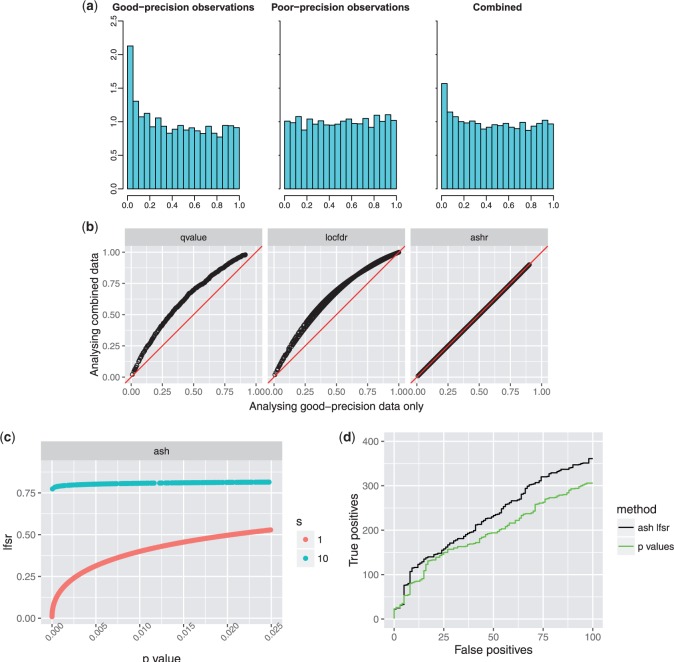
Simulations showing how, with existing methods, but not ash, poor-precision observations can contaminate signal from good-precision observations. (a) Density histograms of \documentclass[12pt]{minimal}
\usepackage{amsmath}
\usepackage{wasysym}
\usepackage{amsfonts}
\usepackage{amssymb}
\usepackage{amsbsy}
\usepackage{upgreek}
\usepackage{mathrsfs}
\setlength{\oddsidemargin}{-69pt}
\begin{document}
}{}$p$\end{document} values for good-precision, poor-precision, and combined observations. The combined data show less signal than the good-precision data, due to the contamination effect of the poor-precision measurements. (b) Results of different methods applied to good-precision observations only (\documentclass[12pt]{minimal}
\usepackage{amsmath}
\usepackage{wasysym}
\usepackage{amsfonts}
\usepackage{amssymb}
\usepackage{amsbsy}
\usepackage{upgreek}
\usepackage{mathrsfs}
\setlength{\oddsidemargin}{-69pt}
\begin{document}
}{}$x$\end{document}-axis) and combined data (\documentclass[12pt]{minimal}
\usepackage{amsmath}
\usepackage{wasysym}
\usepackage{amsfonts}
\usepackage{amssymb}
\usepackage{amsbsy}
\usepackage{upgreek}
\usepackage{mathrsfs}
\setlength{\oddsidemargin}{-69pt}
\begin{document}
}{}$y$\end{document}-axis). Each point shows the “significance” (\documentclass[12pt]{minimal}
\usepackage{amsmath}
\usepackage{wasysym}
\usepackage{amsfonts}
\usepackage{amssymb}
\usepackage{amsbsy}
\usepackage{upgreek}
\usepackage{mathrsfs}
\setlength{\oddsidemargin}{-69pt}
\begin{document}
}{}$q$\end{document} values from qvalue; \documentclass[12pt]{minimal}
\usepackage{amsmath}
\usepackage{wasysym}
\usepackage{amsfonts}
\usepackage{amssymb}
\usepackage{amsbsy}
\usepackage{upgreek}
\usepackage{mathrsfs}
\setlength{\oddsidemargin}{-69pt}
\begin{document}
}{}$\textit{lfdr}$\end{document} for locfdr; \documentclass[12pt]{minimal}
\usepackage{amsmath}
\usepackage{wasysym}
\usepackage{amsfonts}
\usepackage{amssymb}
\usepackage{amsbsy}
\usepackage{upgreek}
\usepackage{mathrsfs}
\setlength{\oddsidemargin}{-69pt}
\begin{document}
}{}$\textit{lfsr}$\end{document} for ash) of a good-precision observation under the two different analyses. For existing methods including the poor-precision observations reduces significance of good-precision observations, whereas for ash the poor-precision observations have little effect (because they have a very flat likelihood). (c) The relationship between \documentclass[12pt]{minimal}
\usepackage{amsmath}
\usepackage{wasysym}
\usepackage{amsfonts}
\usepackage{amssymb}
\usepackage{amsbsy}
\usepackage{upgreek}
\usepackage{mathrsfs}
\setlength{\oddsidemargin}{-69pt}
\begin{document}
}{}$\textit{lfsr}$\end{document} and \documentclass[12pt]{minimal}
\usepackage{amsmath}
\usepackage{wasysym}
\usepackage{amsfonts}
\usepackage{amssymb}
\usepackage{amsbsy}
\usepackage{upgreek}
\usepackage{mathrsfs}
\setlength{\oddsidemargin}{-69pt}
\begin{document}
}{}$p$\end{document}-value is different for good-precision (\documentclass[12pt]{minimal}
\usepackage{amsmath}
\usepackage{wasysym}
\usepackage{amsfonts}
\usepackage{amssymb}
\usepackage{amsbsy}
\usepackage{upgreek}
\usepackage{mathrsfs}
\setlength{\oddsidemargin}{-69pt}
\begin{document}
}{}$s=1$\end{document}) and low-precision (\documentclass[12pt]{minimal}
\usepackage{amsmath}
\usepackage{wasysym}
\usepackage{amsfonts}
\usepackage{amssymb}
\usepackage{amsbsy}
\usepackage{upgreek}
\usepackage{mathrsfs}
\setlength{\oddsidemargin}{-69pt}
\begin{document}
}{}$s=10$\end{document}) measurements: ash assigns the low-precision measurements a higher \documentclass[12pt]{minimal}
\usepackage{amsmath}
\usepackage{wasysym}
\usepackage{amsfonts}
\usepackage{amssymb}
\usepackage{amsbsy}
\usepackage{upgreek}
\usepackage{mathrsfs}
\setlength{\oddsidemargin}{-69pt}
\begin{document}
}{}$\textit{lfsr}$\end{document}, effectively downweighting them. (d) Trade-off between true positives (\documentclass[12pt]{minimal}
\usepackage{amsmath}
\usepackage{wasysym}
\usepackage{amsfonts}
\usepackage{amssymb}
\usepackage{amsbsy}
\usepackage{upgreek}
\usepackage{mathrsfs}
\setlength{\oddsidemargin}{-69pt}
\begin{document}
}{}$y$\end{document}) vs false positives (\documentclass[12pt]{minimal}
\usepackage{amsmath}
\usepackage{wasysym}
\usepackage{amsfonts}
\usepackage{amssymb}
\usepackage{amsbsy}
\usepackage{upgreek}
\usepackage{mathrsfs}
\setlength{\oddsidemargin}{-69pt}
\begin{document}
}{}$x$\end{document}) as the significance threshold (\documentclass[12pt]{minimal}
\usepackage{amsmath}
\usepackage{wasysym}
\usepackage{amsfonts}
\usepackage{amssymb}
\usepackage{amsbsy}
\usepackage{upgreek}
\usepackage{mathrsfs}
\setlength{\oddsidemargin}{-69pt}
\begin{document}
}{}$\textit{lfsr}$\end{document} or \documentclass[12pt]{minimal}
\usepackage{amsmath}
\usepackage{wasysym}
\usepackage{amsfonts}
\usepackage{amssymb}
\usepackage{amsbsy}
\usepackage{upgreek}
\usepackage{mathrsfs}
\setlength{\oddsidemargin}{-69pt}
\begin{document}
}{}$p$\end{document} value) is varied. By downweighting the low-precision observations ash re-orders the significance of observations, producing more true positives at a given number of false positives. It is important to note that this behaviour of ash depends on choice of \documentclass[12pt]{minimal}
\usepackage{amsmath}
\usepackage{wasysym}
\usepackage{amsfonts}
\usepackage{amssymb}
\usepackage{amsbsy}
\usepackage{upgreek}
\usepackage{mathrsfs}
\setlength{\oddsidemargin}{-69pt}
\begin{document}
}{}$\alpha$\end{document}. See Section 3.2.1 for discussion.